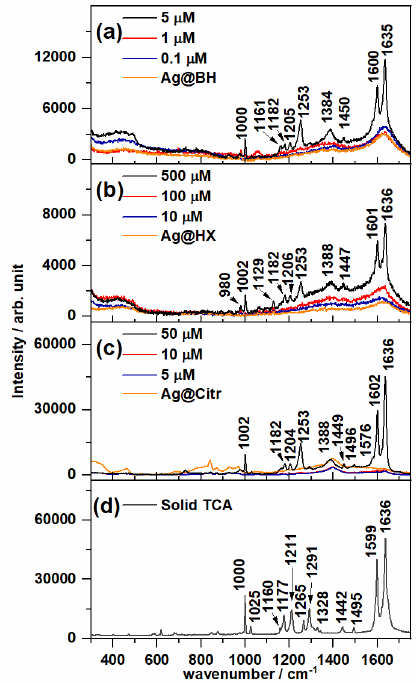
Figure 3. Surface-enhanced Raman spectroscopy (SERS) spectra of trans-cinnamic acid (TCA) recorded at different concentrations using ( a ) Ag@BH, ( b ) Ag@HX and ( c ) Ag@Citr NPs. The respective Raman spectra of colloids are also shown. ( d ) Raman spectra of solid TCA.